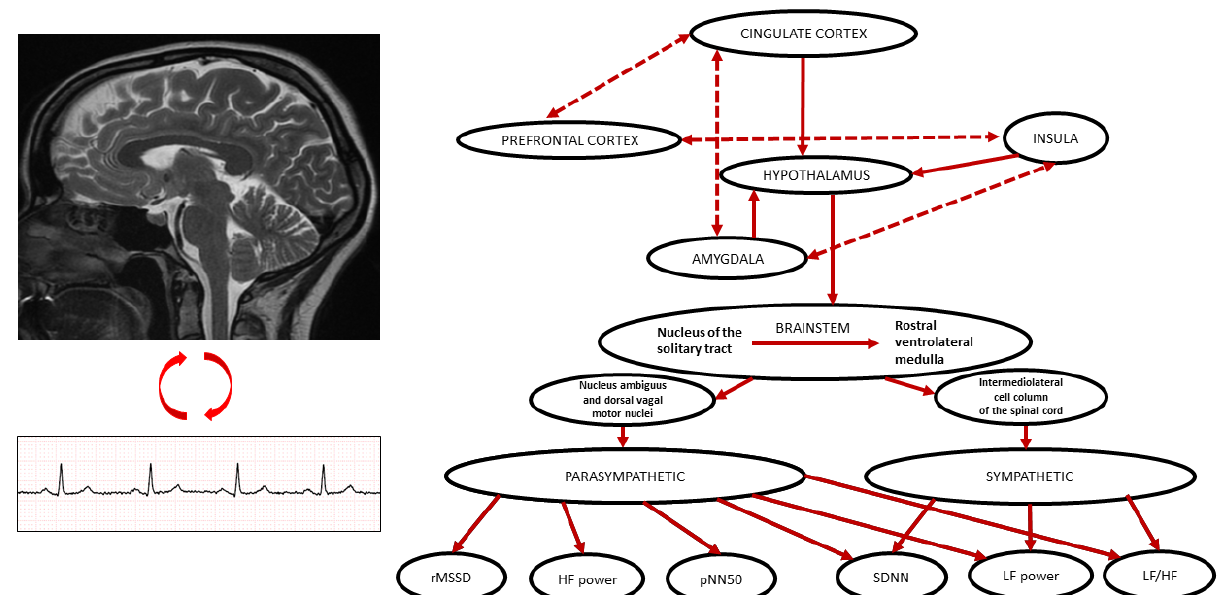
Figure 1. A simplified representation of the connections between neural structures and heart rate variability measures. Based on: [3,4]. Abbreviations: HF power — high frequency power; LF power — low frequency power; pNN50 — percentage of successive NN intervals that differ by more than 50 ms; rMSSD — root mean square of successive variances of NN intervals; SDNN — standard deviation of NN intervals.